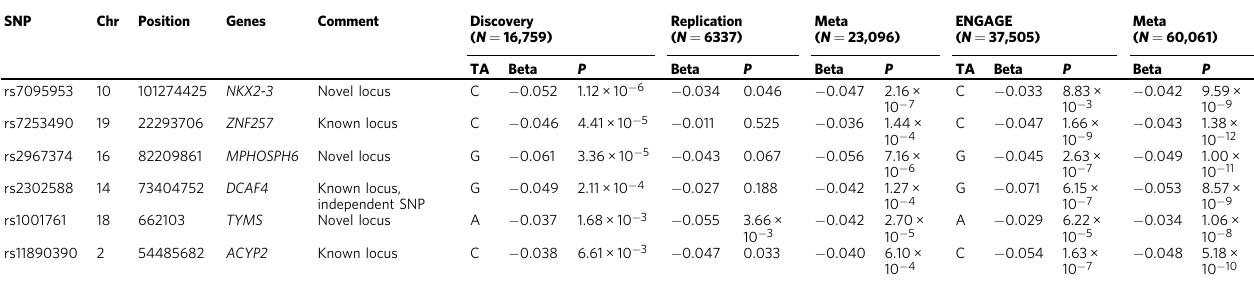
Table 2 Summary statistics of genome-wide hits identi fi ed after trans-ethnic meta-analysis SNP Chr